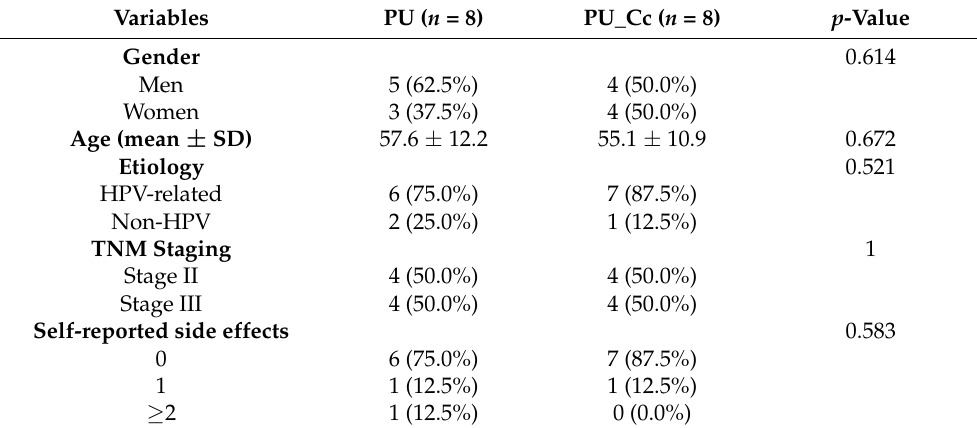
Table 3. Background characteristics and medication dynamics among study participants.